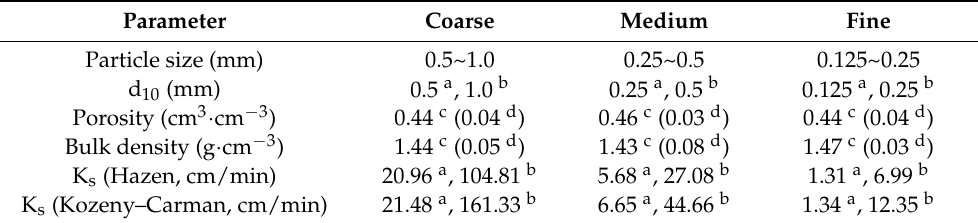
Table 2. Estimated parameter values for the empirical